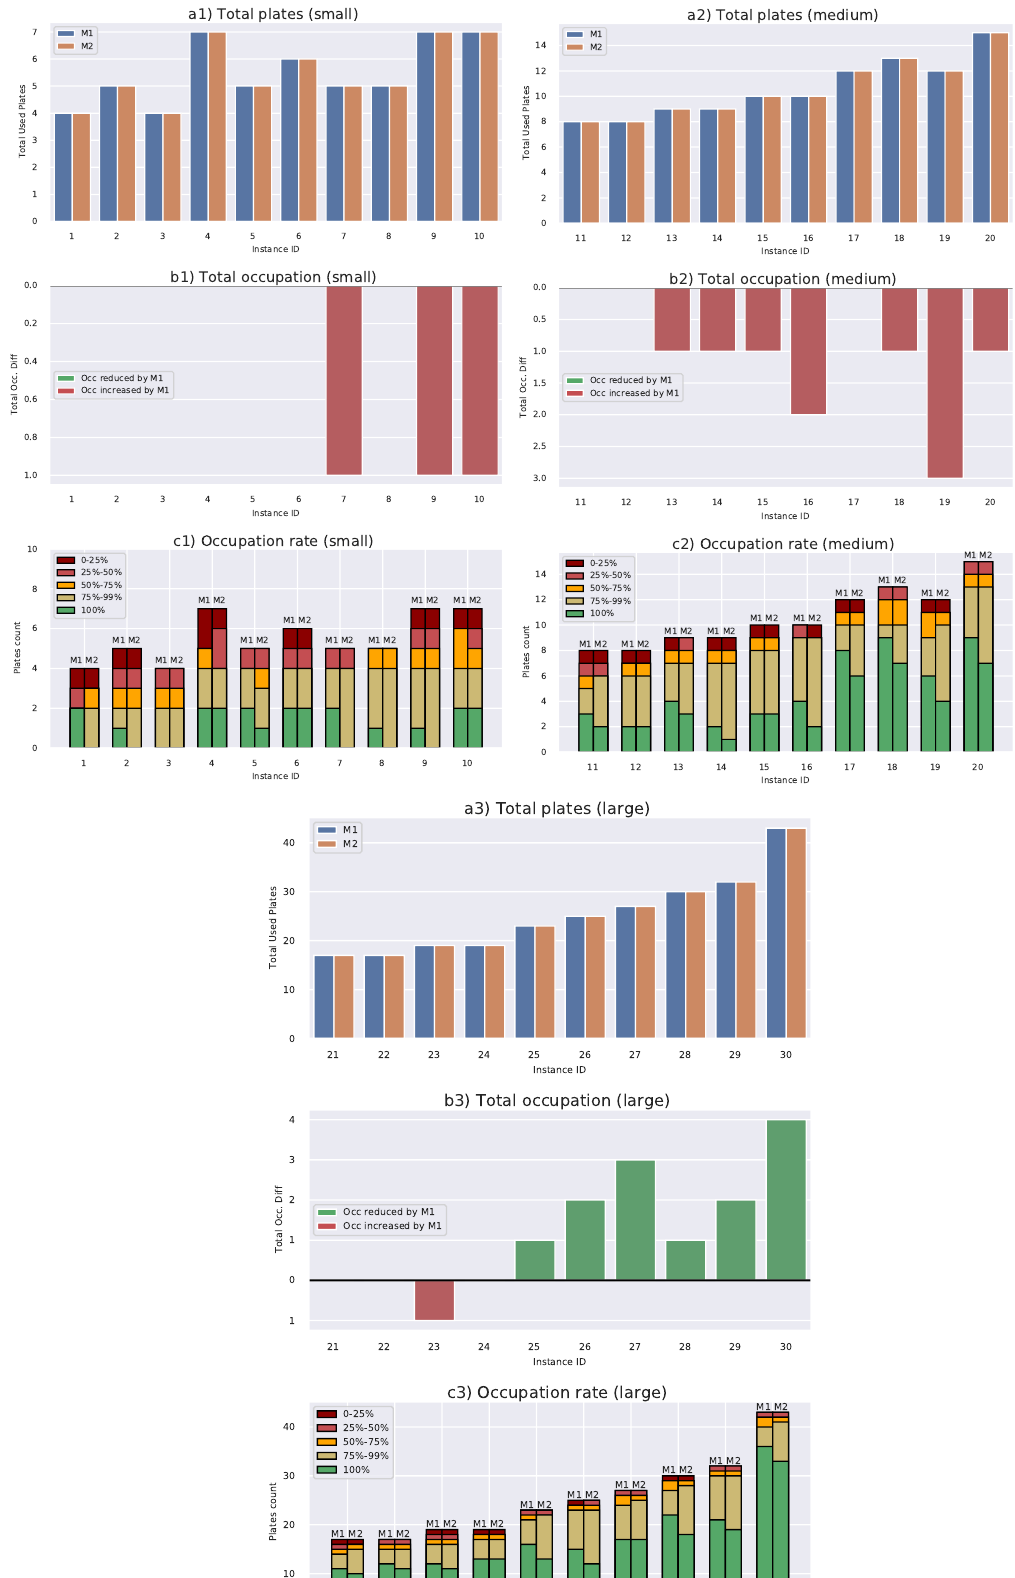
Figure 11. Comparison of M1 and M2 on all available